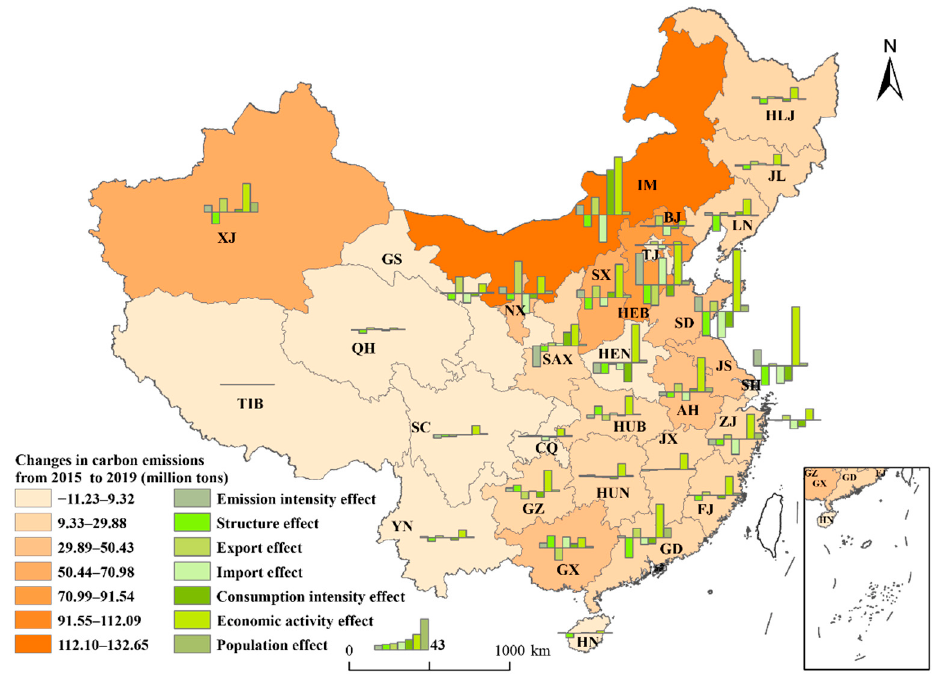
Figure 9. Provincial changes in carbon emissions and driving forces during 2015–2019.